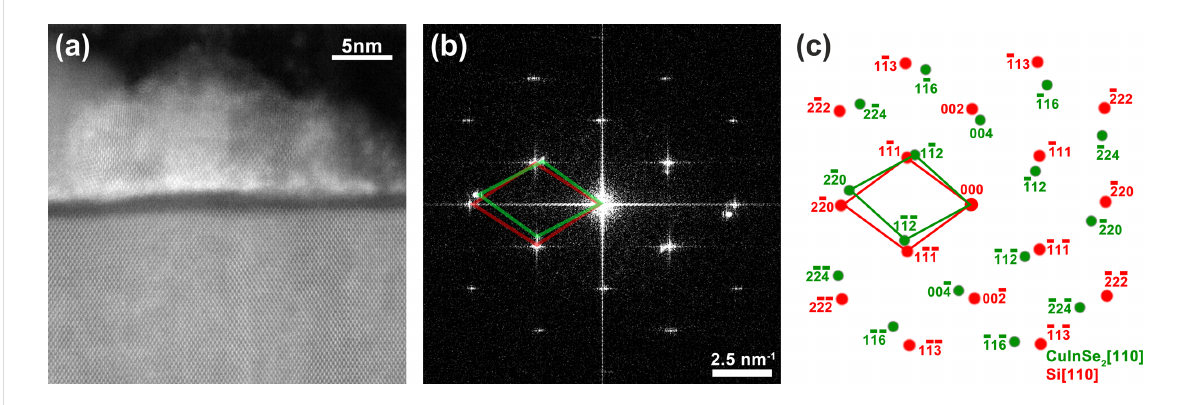
Figure 2: (a) High-resolution HAADF image of a nanodot on top of the amorphous SiO 2 layer, taken along the [110] zone axis of the Si substrate. (b) Power spectrum of the HAADF image, showing the nanodot and Si substrate lattices. (c) Extracted pattern showing the indexed diffraction spots of the nanodot (green) and Si substrate (red).